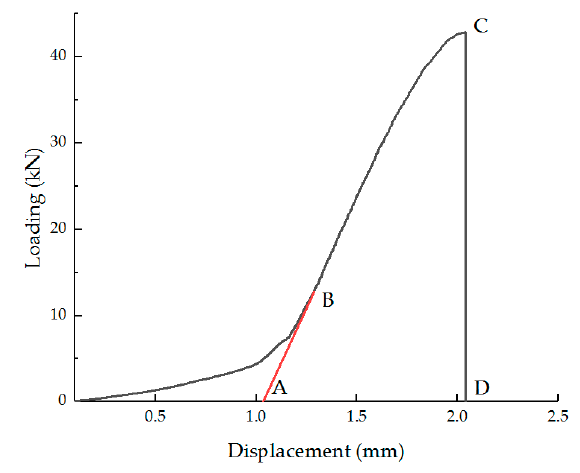
Figure 2. Load–deformation curve.